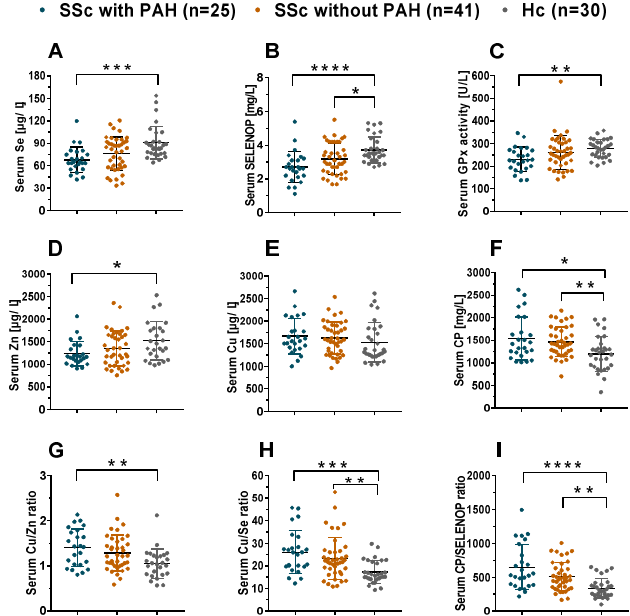
Figure 2. Comparison of TE status and composite biomarkers of TE in SSc patients versus controls. Patients suffering from SSc-PAH display reduced serum Se and Zn status as compared to healthy controls (HC). Differences are observed for ( A ) total Se and, ( B ) serum SELENOP concentrations, as well as ( C ) serum GPx3 activity and ( D ) total serum zinc (Zn) concentrations. In comparison, ( E ) total serum Cu concentrations do not differ between the groups. Concentration of the Cu transporter CP is elevated in SSc-PAH patients as compared to HC. Similar differences are detected for ( F ) serum ceruloplasmin (CP) concentrations, ( G ) serum Cu/Zn ratio, ( H ) serum Cu/Se ratio, and ( I ) serum CP/SELENOP ratio. Comparisons were analysed by Kruskal-Wallis statistics and Dunn’s multiple comparisons test. All tests were two-sided and p -values < 0.05 were considered statistically significant; * indicates p < 0.05, ** indicates p < 0.01, *** indicates p < 0.001 and **** indicates p < 0.0001. Besides Se, the biomarkers of Cu and Zn status were also analyzed. Total serum Zn concentrations were relatively low in SSc-PAH as compared to HC (Figure 2D), whereas total serum Cu concentrations were not different between the groups (Figure 2E). The protein biomarker of Cu status, i.e., ceruloplasmin (CP), was elevated in SSc, both in patients with and in patients without PAH, as compared to HC (Figure 2F). TE status was also analysed by composite biomarkers, that may provide more sensitive information. To this end, ratios were built between serum TE and the protein biomarkers, respectively. In this analysis, consistently elevated values in the patients are observed for the Cu/Zn ratio (Figure 2G), Cu/Se ratio (Figure 2H) and CP/SELENOP ratio (Figure 2I), respectively. The N-terminal pro-B-type natriuretic peptide (NTproBNP) has been shown as valuable biomarker for heart failure, and NTproBNP concentrations are elevated in patients suffering from SSc-PAH [44]. A direct comparison of the TE concentrations, the protein biomarkers and their ratios